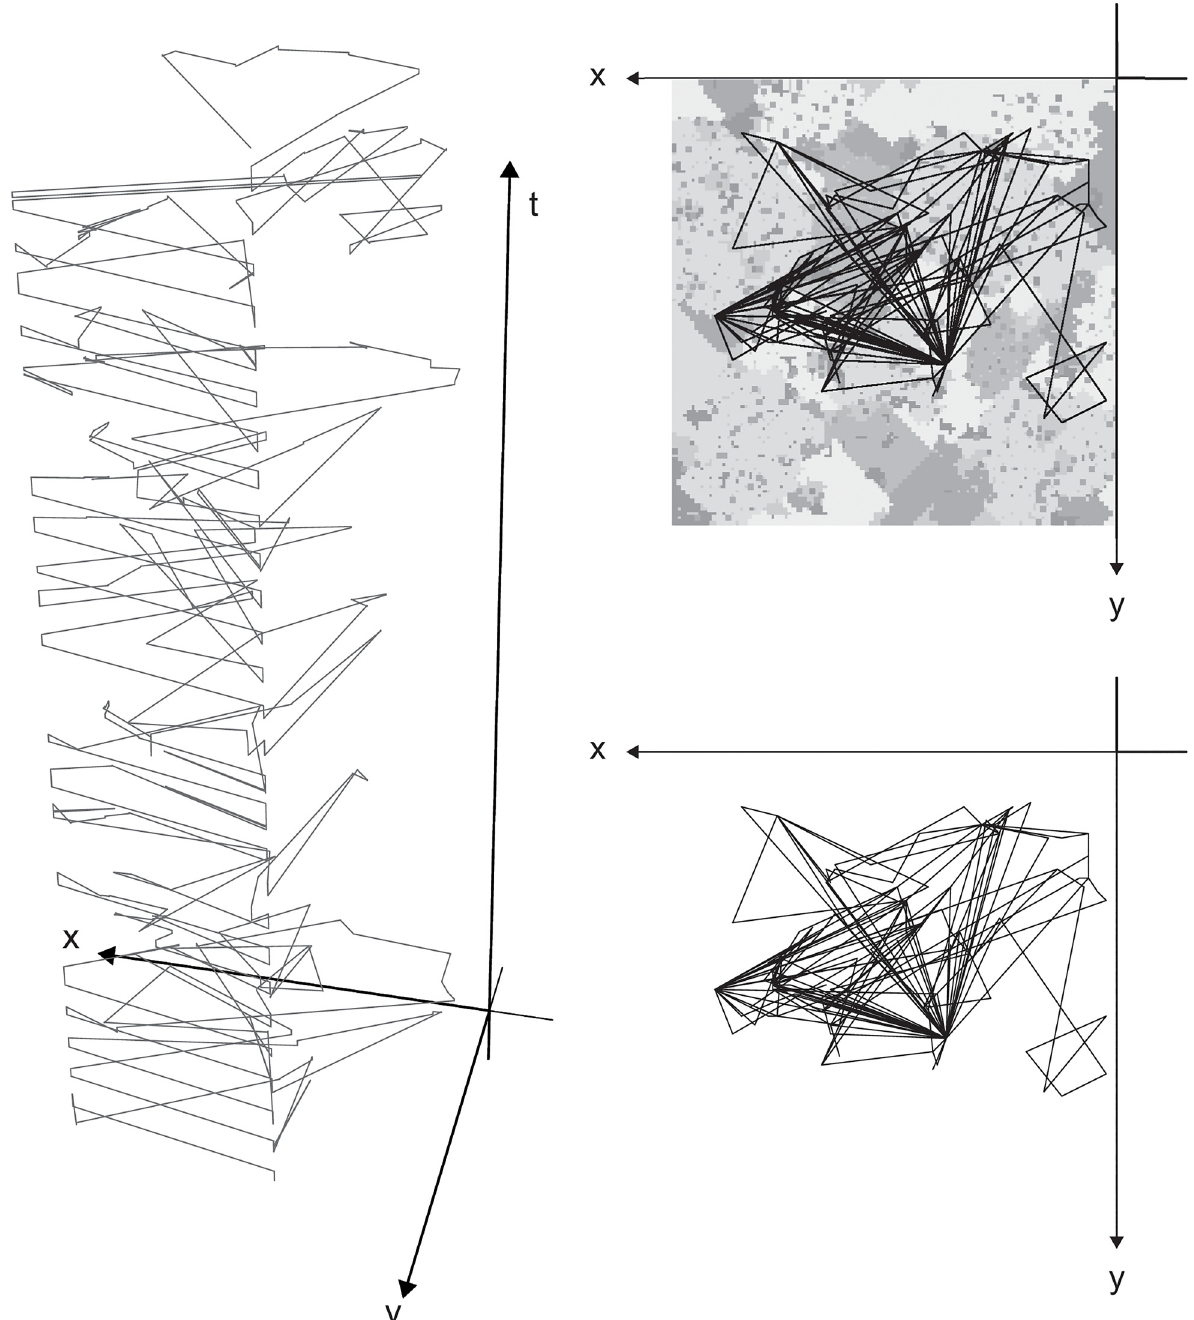
Fig 3. Spatio-temporal representation of an agent ’ s movement during one month. X and Y axes represent space while the Z axis represents time. The agent ’ s movements are represented by the lines. Note that there is on obvious regularity in the agent ’ s movement.